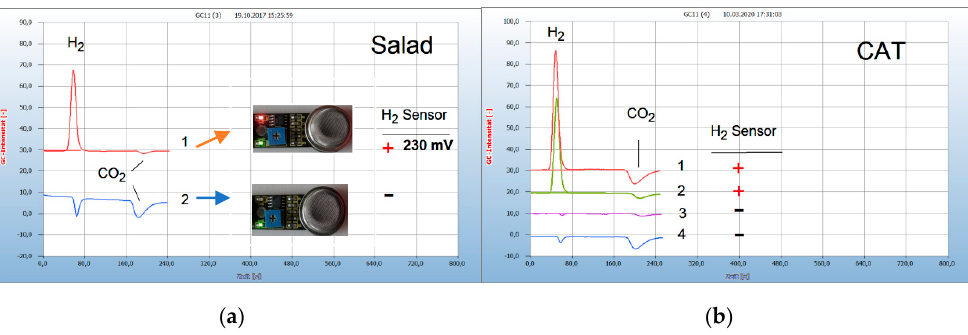
Figure 2. Obligate anaerobes, facultative anaerobes, and obligate aerobes by headspace gas chromatography (HS-GC) and the H 2 sensor approach. Gas chromatography: column Silicagel, carrier gas ambient air. H 2 emission ( + ), no H 2 emission ( − ). ( a ) Chopped salad leaves in 20 mL headspace vials, no culture broth; culture time 15 h; 1 = salad packed in plastic container with facultative anaerobes ( + ), 2 = salad unpacked with aerobes ( − ). ( b ) Feces from a cat in a 6 mL headspace vial with 2.5 mL culture broth; 1 = feces with obligate anaerobes (H 2 ) and aerobes (CO 2 ) under headspace gas